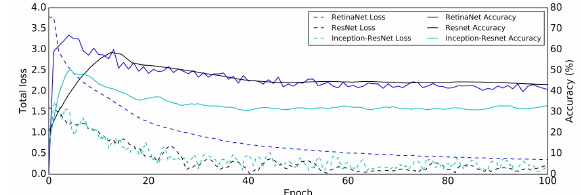
Figure 4: Training loss and validation accuracy (IoU=0.5) for each of the network architectures. Accuracy is comparably lower to papers cited in the methodology section. The training loss appears to have converged well.